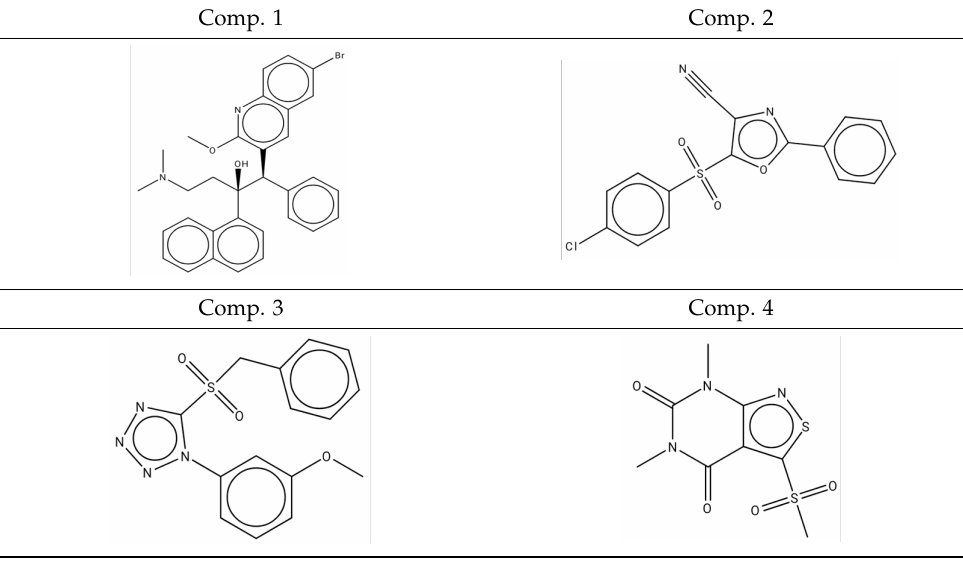
Table 2. 2D Chemical structures of the best active